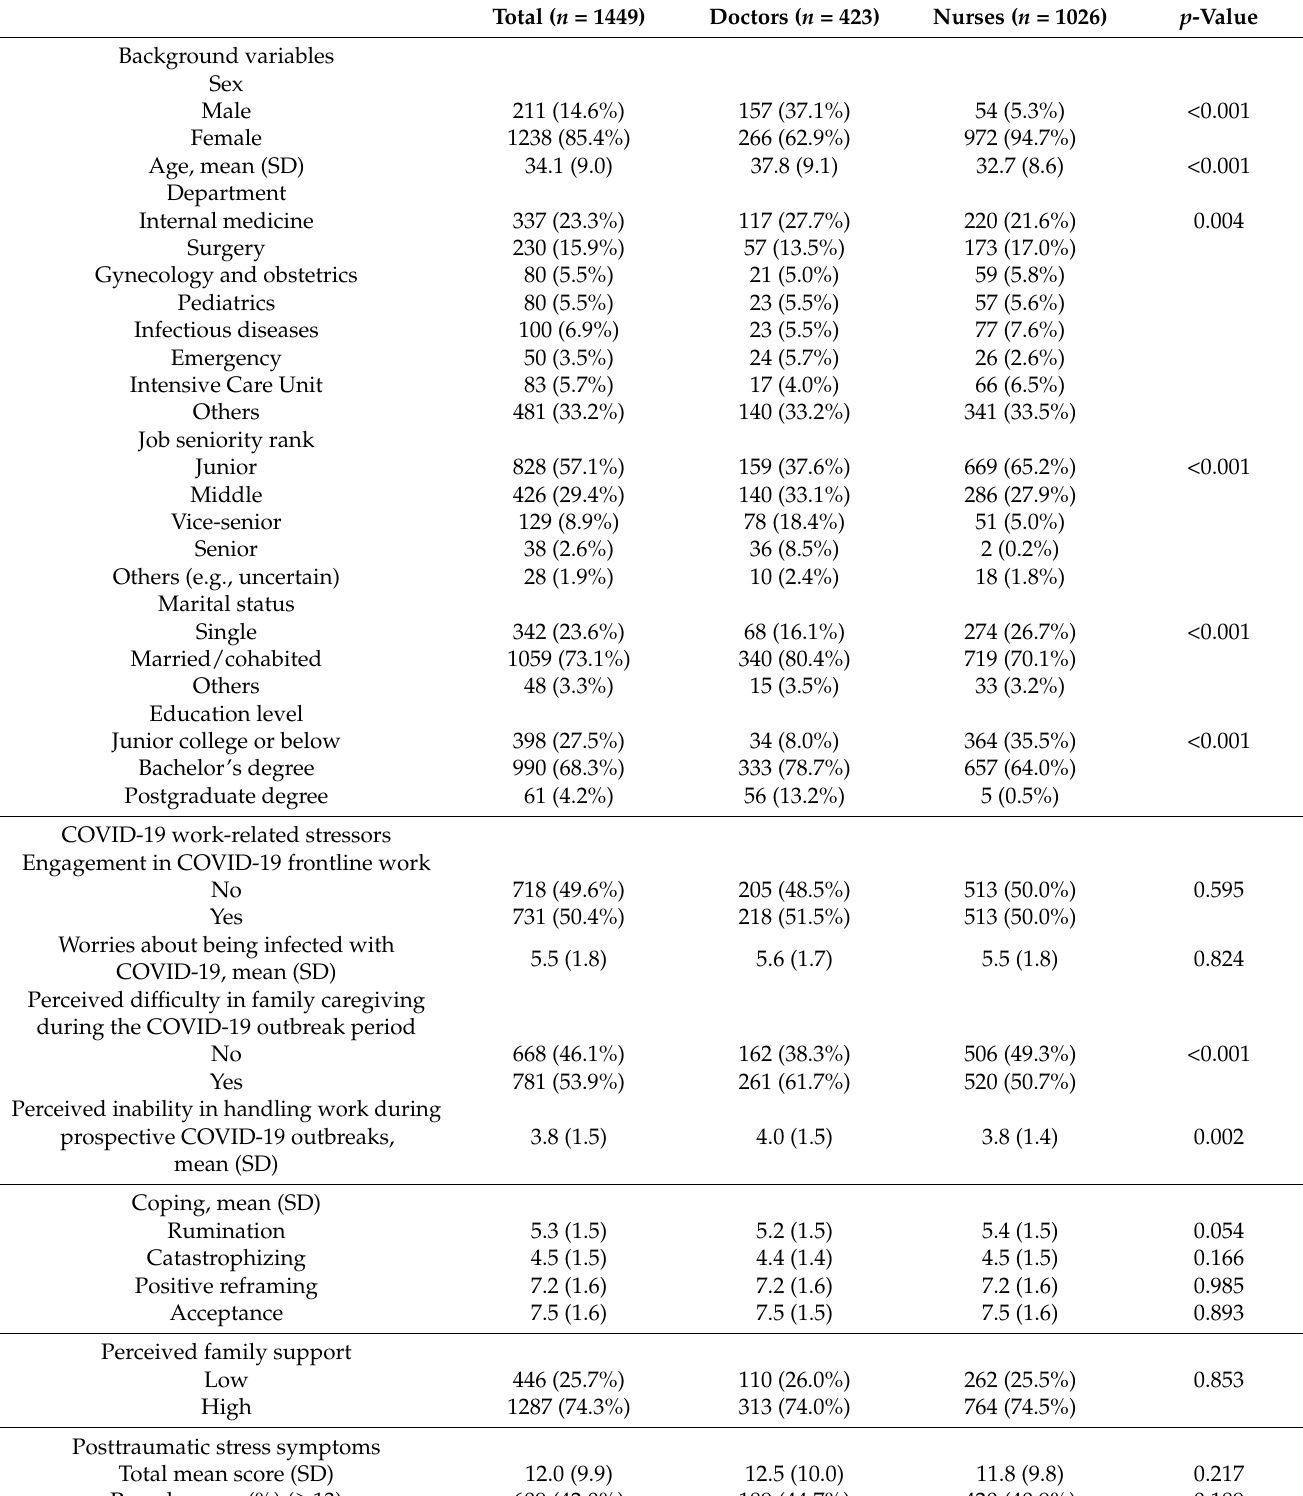
Table 1. Description of the study participants’ characteristics ( n =